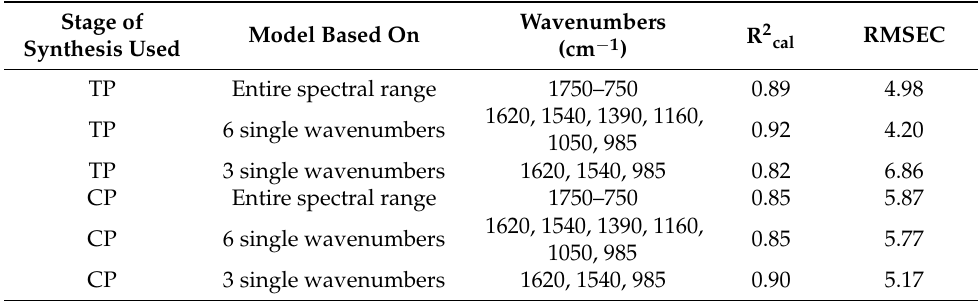
Table 3. Statistics of PLS models calculated with two factors for spectral information obtained at two different stages of the synthesis, endpoint (TP) and the clear point